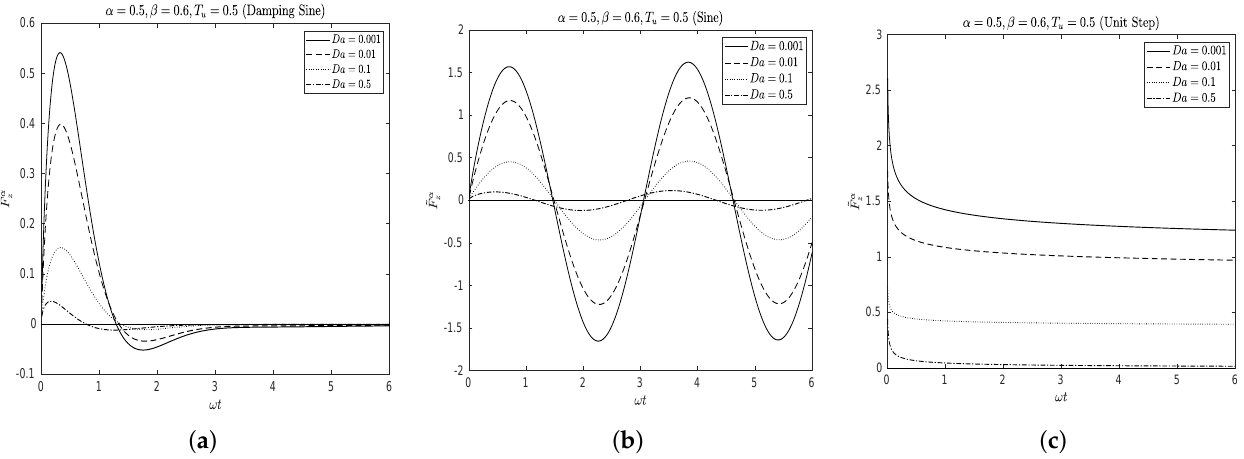
Figure 6. Variation of drag force at different Da for all three cases: ( a ) damping sine oscillation, ( b ) sine oscillation, ( c ) Unit step